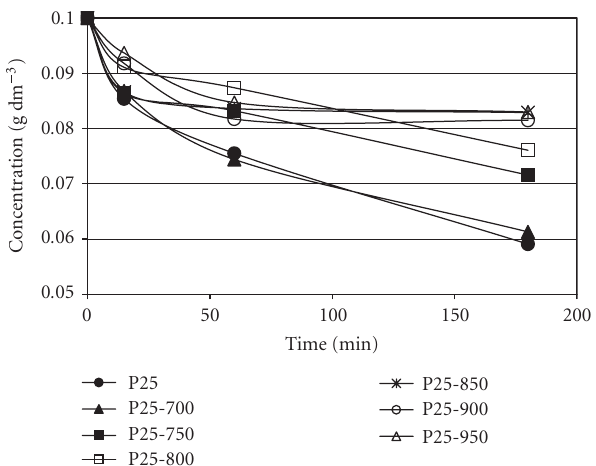
Figure 3: Changes in concentration of phenol during the photocat- alytic reaction for P25 photocatalyst samples. Initial concentration of phenol − 0 . 1gdm − 3 , photocatalyst amount − 0 . 2gdm − 3 .